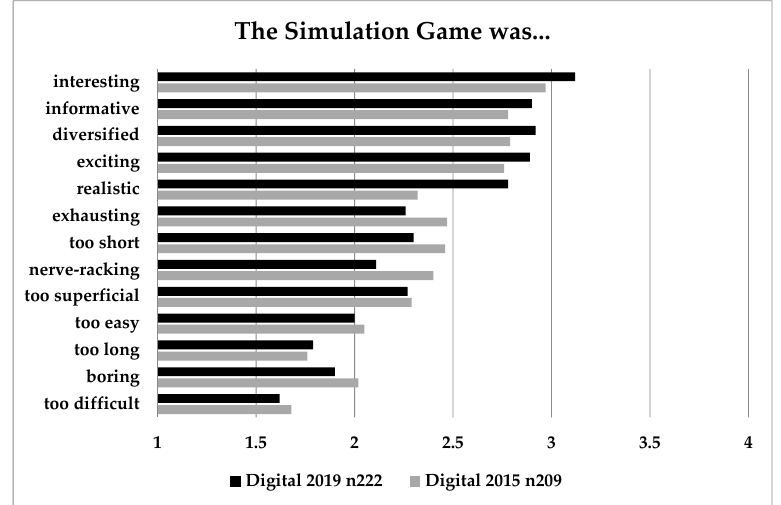
Figure 1. Comparison Simulation Game Adjectives Assessed by Participants in 2015/2016 and 2019/2020; 1 Indicates Strong Rejection and 4 Strong Agreement.